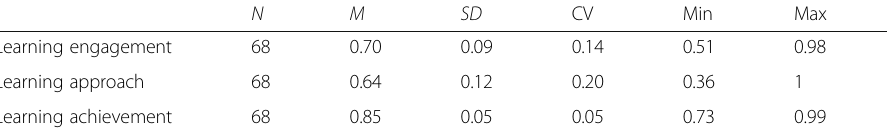
Table 3 Summary descriptive statistics for indicators of citizen learning experiences N M SD CV Min